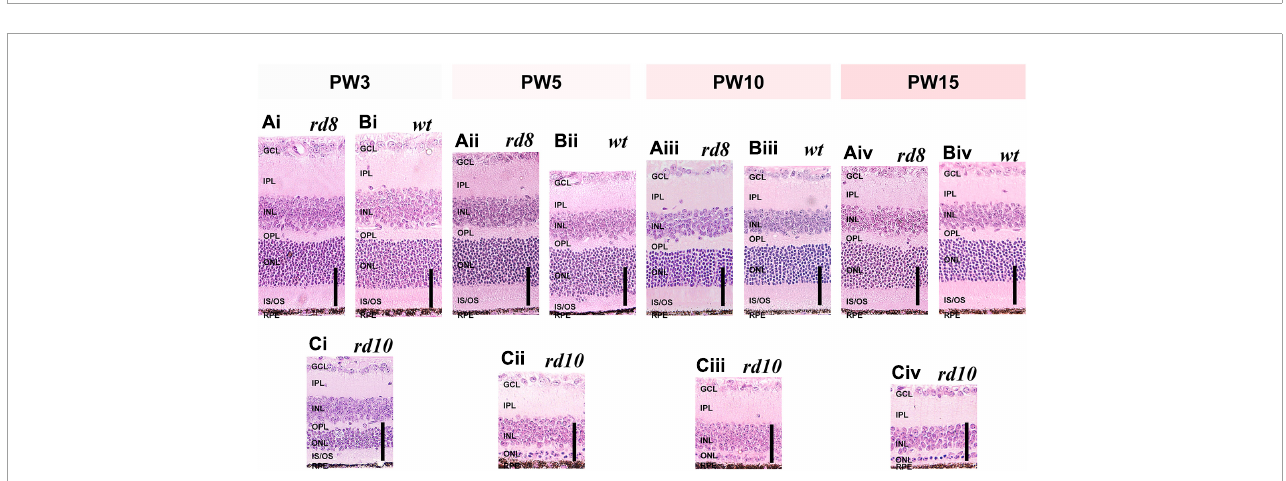
FIGURE3 Histological analyses show similar thickness changes of retinal layers as a function of ages in rd8 and wild-type ( wt ) retinas while rd10 retinas show remarkably thickness decrement. (Ai–Aiv) H&E staining images of rd8 retinas of mice at four age groups: postnatal weeks (PW) 3, 5, 10, and 15, respectively. (Bi–Biv) Same as panel (A) but for age-matched wt mouse retinas. (Ci–Civ) Same as panel (A) but for age-matched rd10 mouse retinas. Profound thinning is observed in both ONL and IS/OS layer. Each vertical scale bar at bottom right of every panel indicates 50 µ m. GCL: ganglion cell layer, IPL: inner plexiform layer, INL: inner nuclear layer, OPL: outer plexiform layer, ONL: outer nuclear layer, IS/OS: inner segment/outer segment of photoreceptor, RPE: retinal pigment